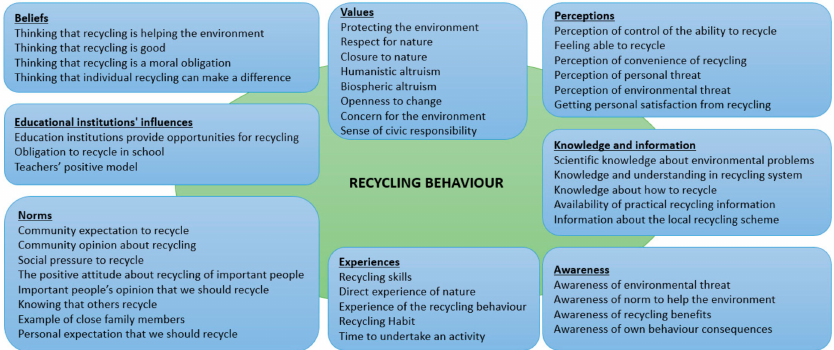
Figure 2. Influencing factors for recycling behavior which can be addressed by